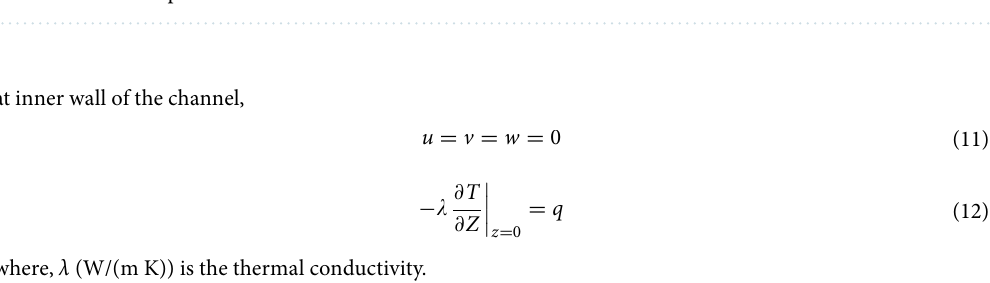
Table 2. Grid independence